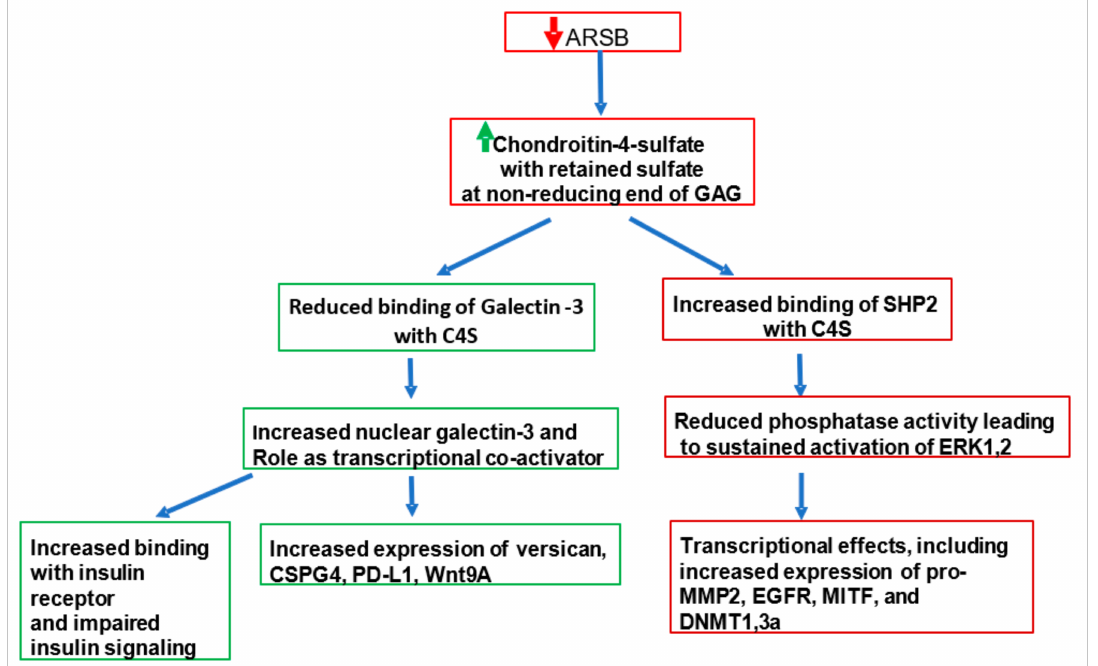
Figure 4. Mechanisms leading to impaired cell signaling and transcriptional events. Decline in ARSB leads to accumulation of chondroitin 4-sulfate and dermatan sulfate. Decline in ARSB may be due to congenital mutation, hypoxia, increased exposure to chloride or phosphate, estrogen, ethanol, carrageenan, or other exposures, as indicated in Table 2 and Section 4. The signaling pathways were explored with chondroitin 4-sulfate (C4S), since a C4S antibody which detected C4S chains was available. Two major pathways are affected by increased C4S, as shown. Galectin-3 binds less to more highly sulfated C4S and becomes available for other interactions, including increased binding with the insulin Receptor, leading to inhibition of insulin signaling [80–82] and increased binding with transcription factors, enabling increased DNA binding and transcriptional effects [27,32–35]. In contrast, SHP2 binds more with C4S when ARSB is silenced, leading to reduced phosphatase activity [14,28,33,36–38] and sustained phosphorylation of critical signaling molecules, including phospho-ERK1,2 [33,36,83], phospho-JNK [28], and phospho-p38 MAPK [14,38]. Due to the complexity of the phospho-proteome, the manifestations of sustained phosphorylations impact multiple signaling events. These include increased c-Myc activation of DNMTs and increased methylation of DKK3, which when active acts as an inhibitor of Wnt signaling